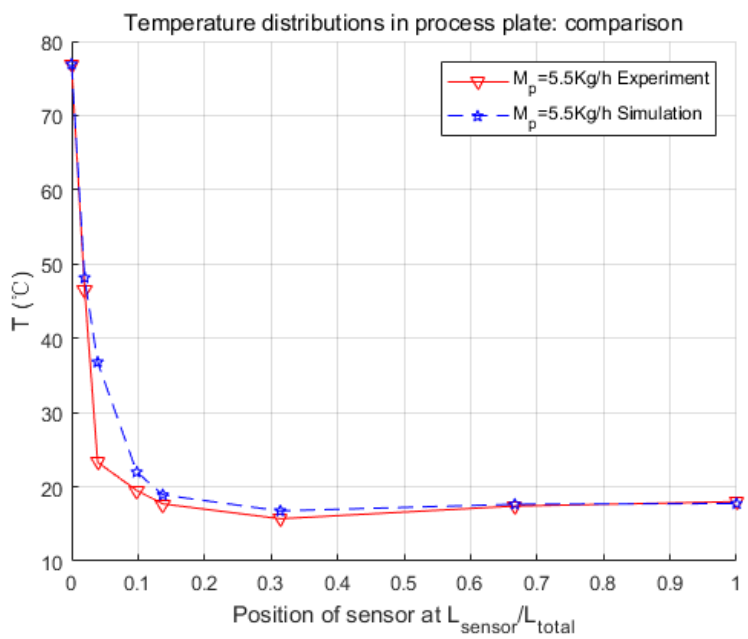
. M u = 152 kg · h − 1 and